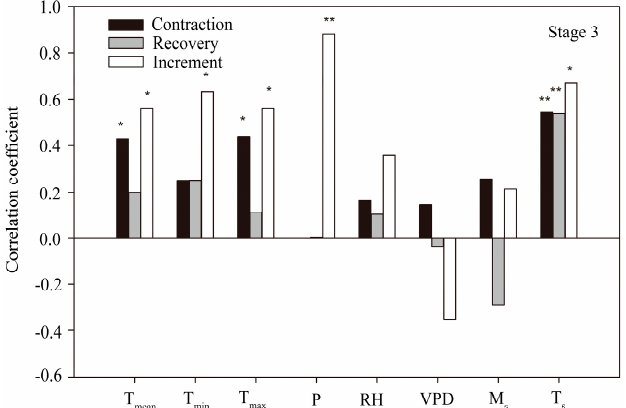
Figure 6. Spearman correlations of amplitude of stem radius variation and air temperature (mean, T mean ; minimum, T min ; and maximum, T max ), precipitation (P), relative humidity (RH), vapor pressure deficit (VPD), soil moisture (M s ), and soil temperature (T s ) during stages 1, 2, and 3. * p < 0.05; ** p < 0.01.